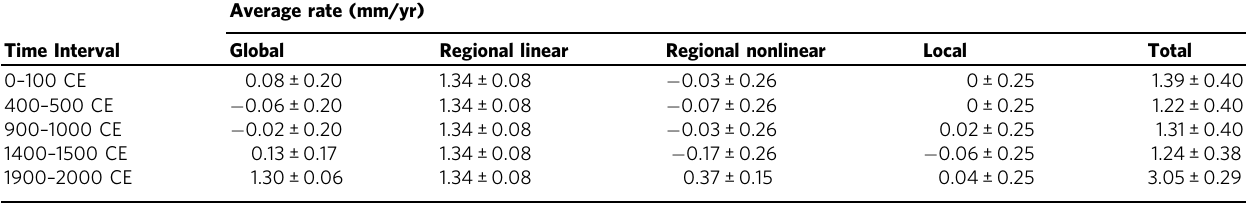
Table 1 Common Era sea-level budget for northern New Jersey for fi ve 100-year time